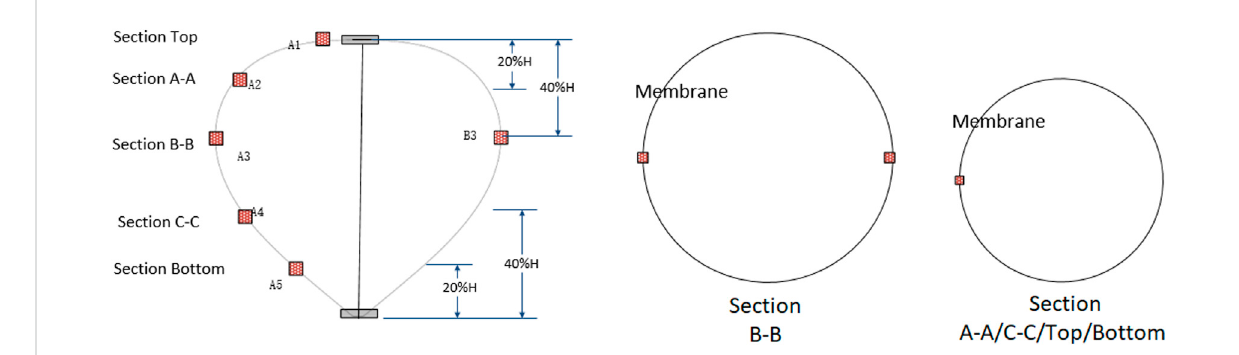
FIGURE 3 Strain gauge on the membrane.